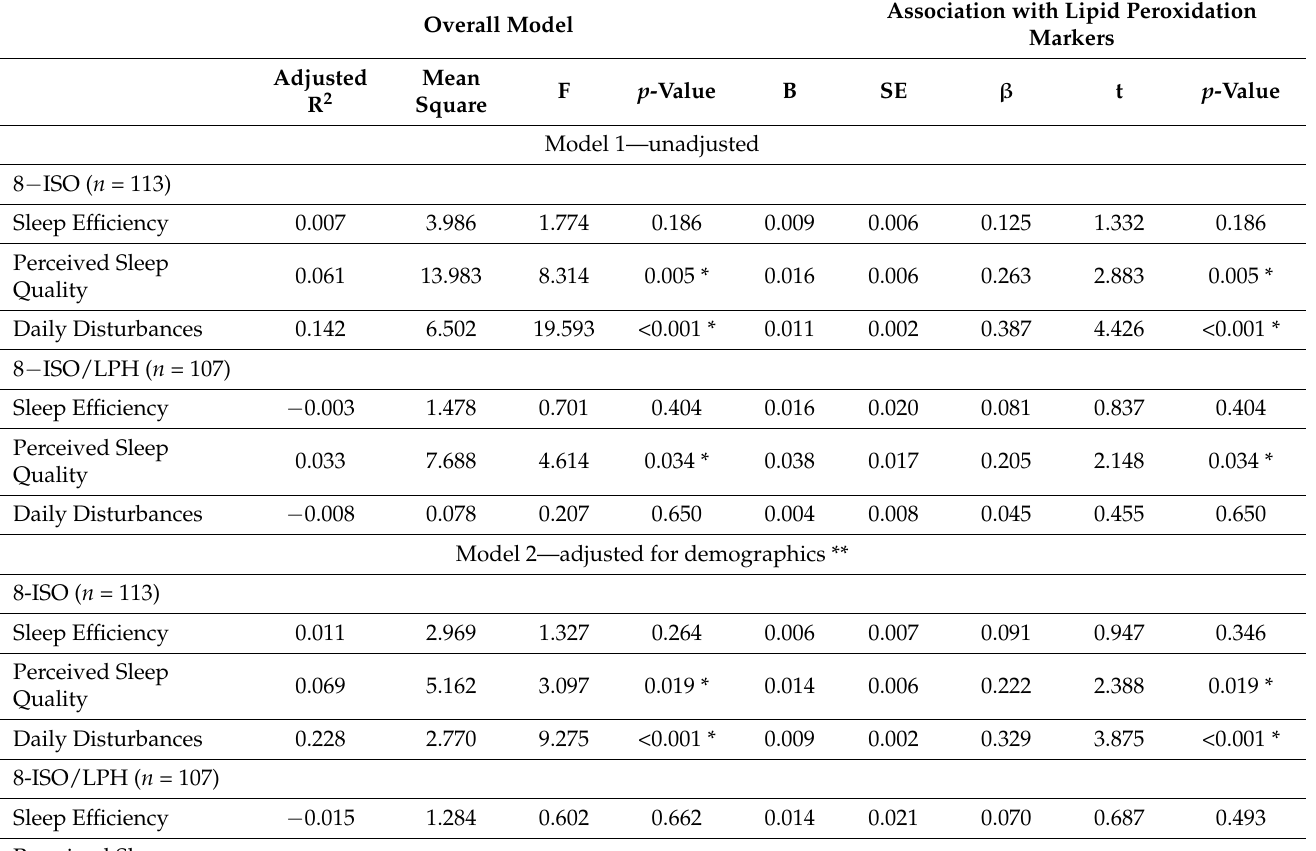
Table 2. Results of linear regression models using 8-ISO and 8-ISO/LPH as predictor variables for baseline sleep